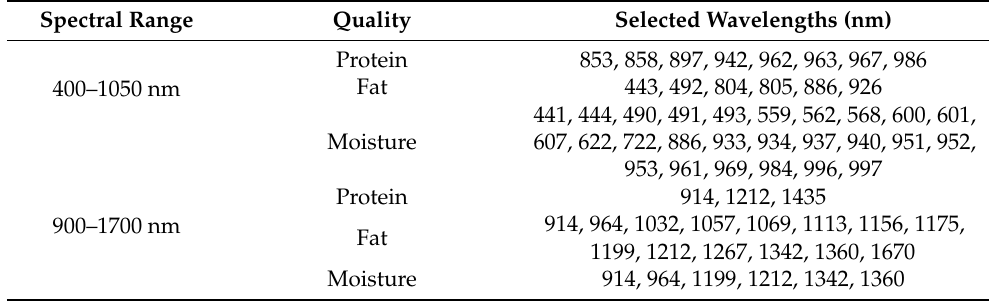
Table 4. Characteristic wavelengths of quality parameters based on stepwise regression algorithm.